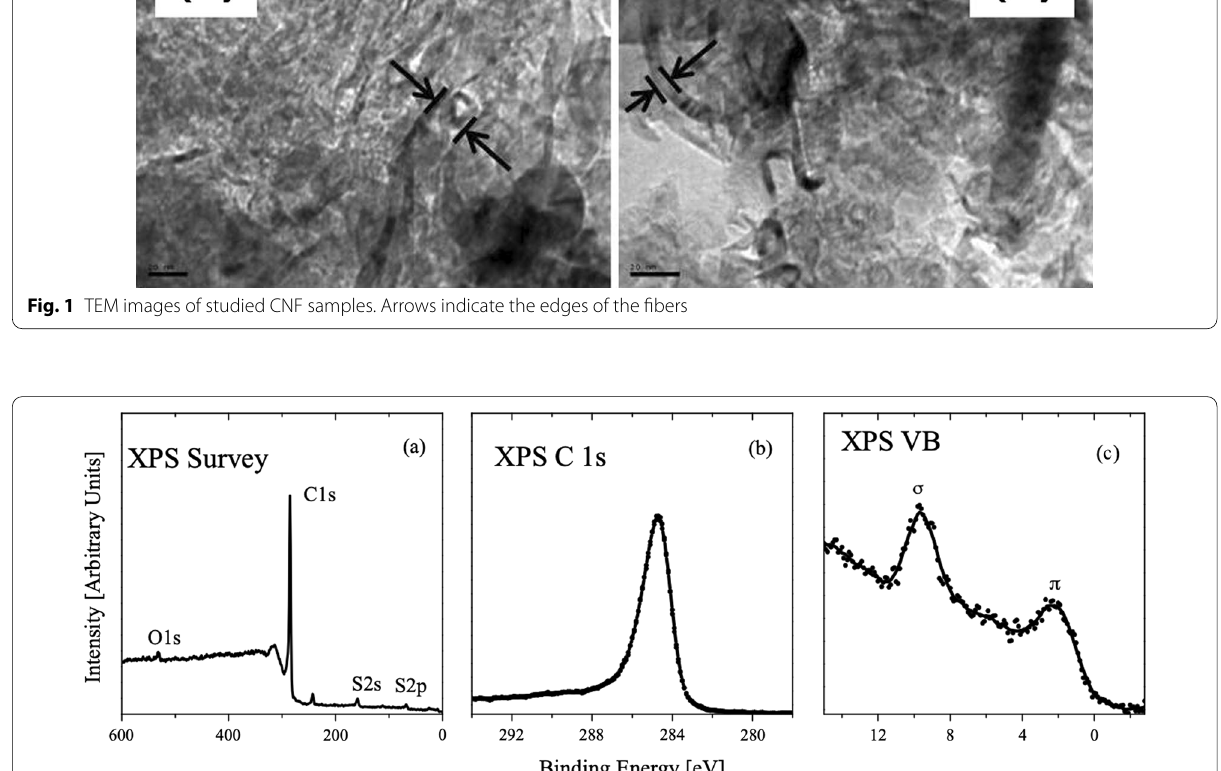
Fig. 2 XPS survey ( a ), C 1 s b valence band and c spectra of CNF